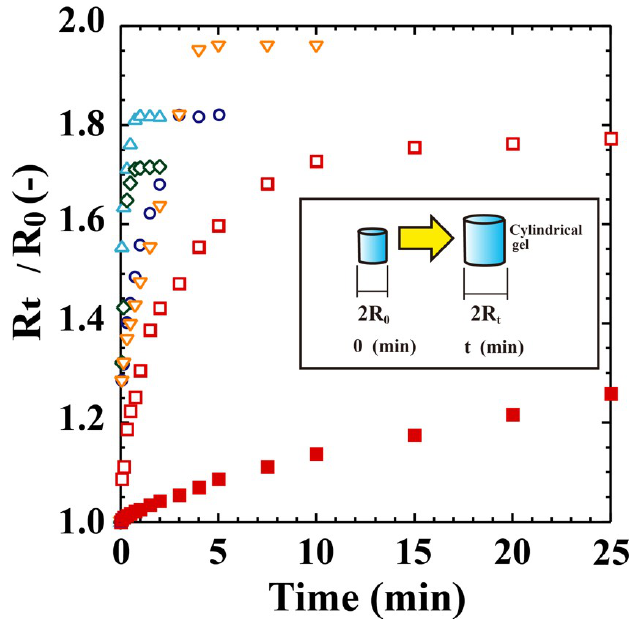
Figure 2. Swelling behaviours of POEGA gels in pure water at 10 °C. △ : PeDEGA, 〇 : PDEGA, ◇ : PTEGA,